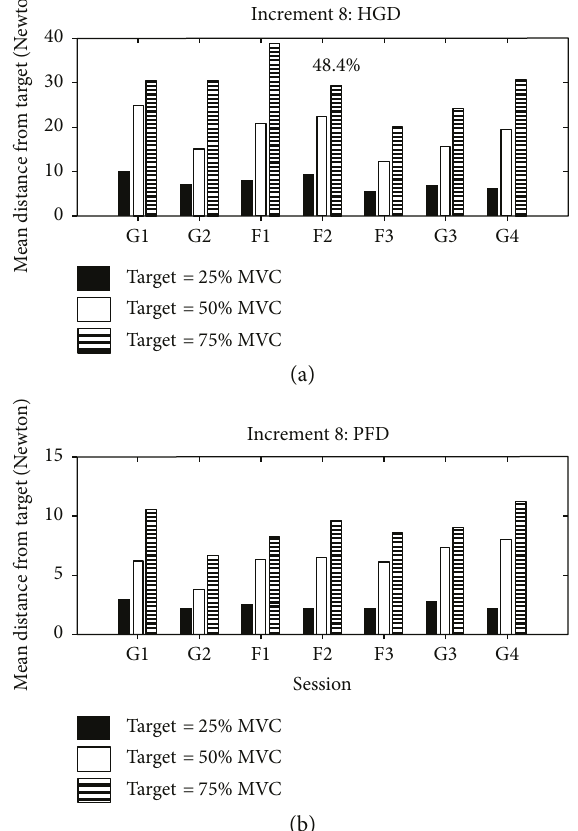
Figure 4: Mean distance from target (MDT). (a) Analysis for handgrip dynamometer (HGD) tests. (b) Analysis for pinch force dynamometer (PFD) tests. The timing of the di ff erent sessions is reported in Materials and